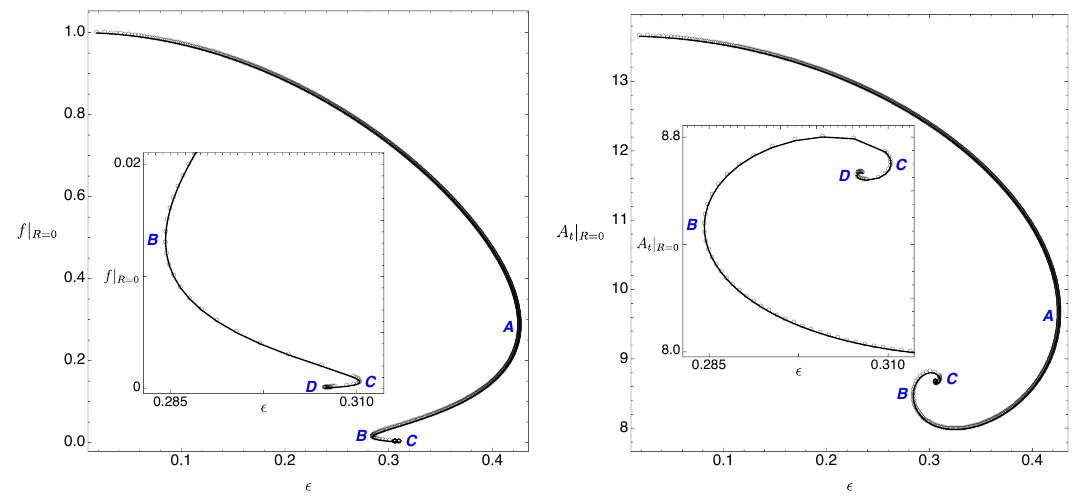
Figure 4 . Main soliton family with e = 0 . 23 ( e < e γ ). Left panel: as we ramp up the value of the amplitude (cid:15) ≡ φ 0 (1) the core value of the metric function f is (very) slowly approaching zero. The inset plot zooms in the damped oscillations around the turning points B, C, D . Right panel: contrast this with the core value of the gauge field A which is spiralling inward indefinitely as (cid:15) is ramped up. The inset plot zooms in the spirals around the turning points B, C, D